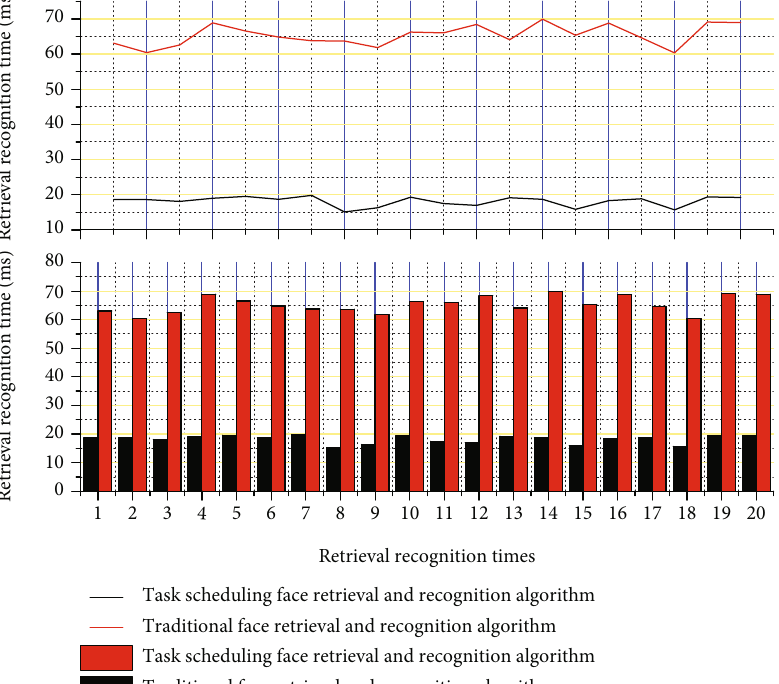
Figure 6: Time required for face detection.